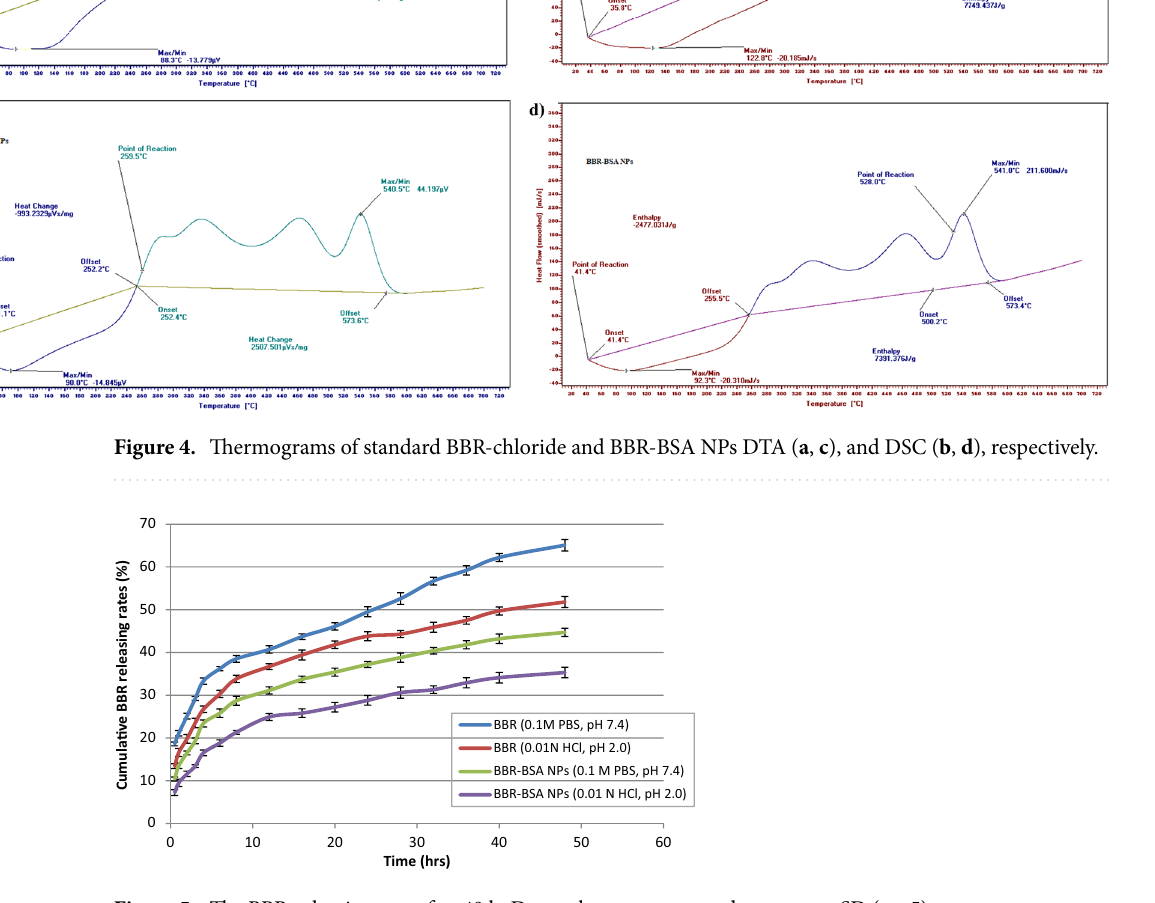
Figure 5. The BBR-releasing rate after 48 h. Data values are expressed as means ± SD (n =